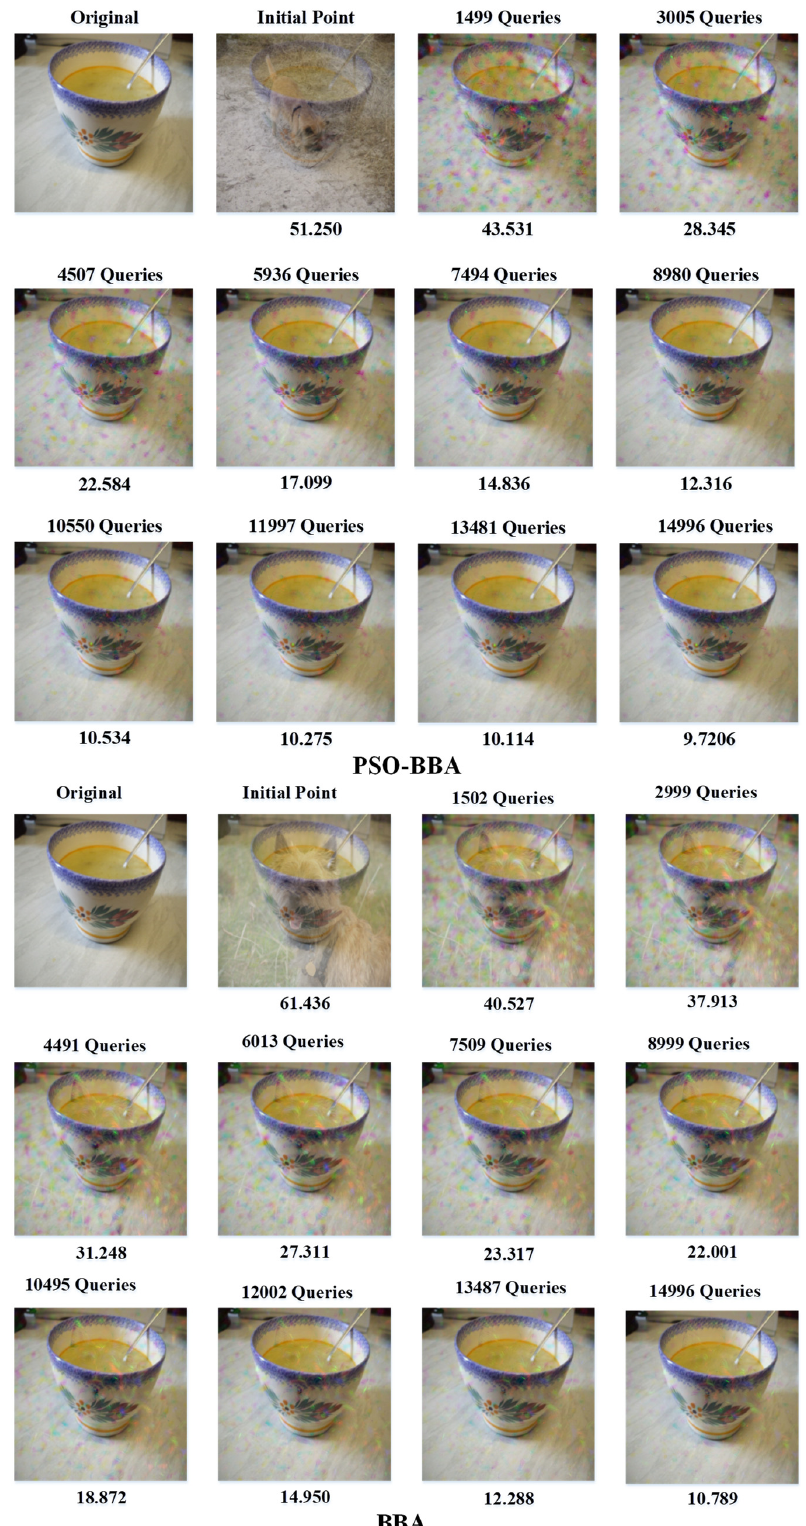
Figure 5. Comparison of the average distortion (L2 distance) in each iteration between the proposed PSO-BBA and the original BBA algorithm.